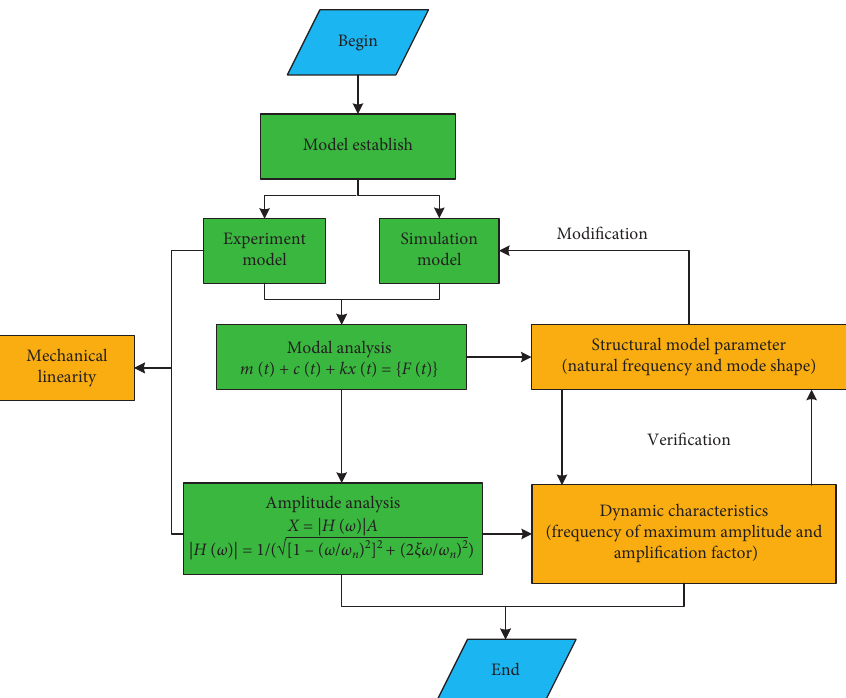
Figure 2: Flow chart for the proposed